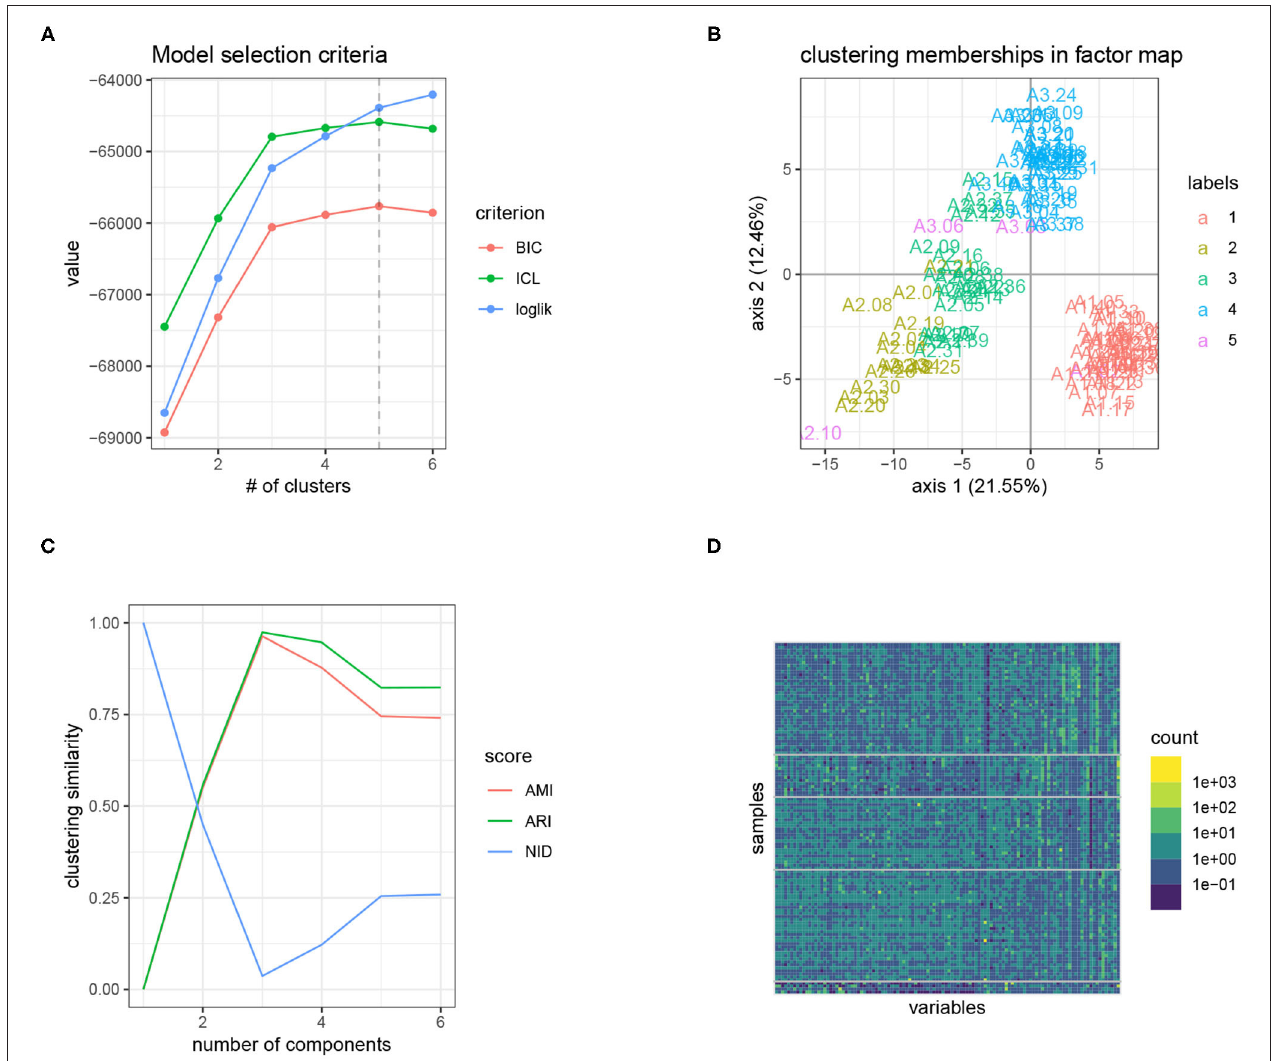
FIGURE 4 | Result of the analysis of the oaks powdery mildew data set with PLN-mixture: the tree susceptibility to the pathogen is easily recovered, and seems to strongly structure the data set. (A) Model selection criteria used to select the number of component: (ICL chooses 5 clusters). (B) Scatter-plot after dimension reduction, with samples colored according to the clustering found. (C) Similarity between the inferred clustering and tree susceptibility with standard comparison measures. A high similarity yields in high AMI and ARI, but low NID. (D) Matrix of counts re-ordered (log-scale): the blocks share much with the level of susceptibility. The first two blocks the more heterogenous group of susceptible